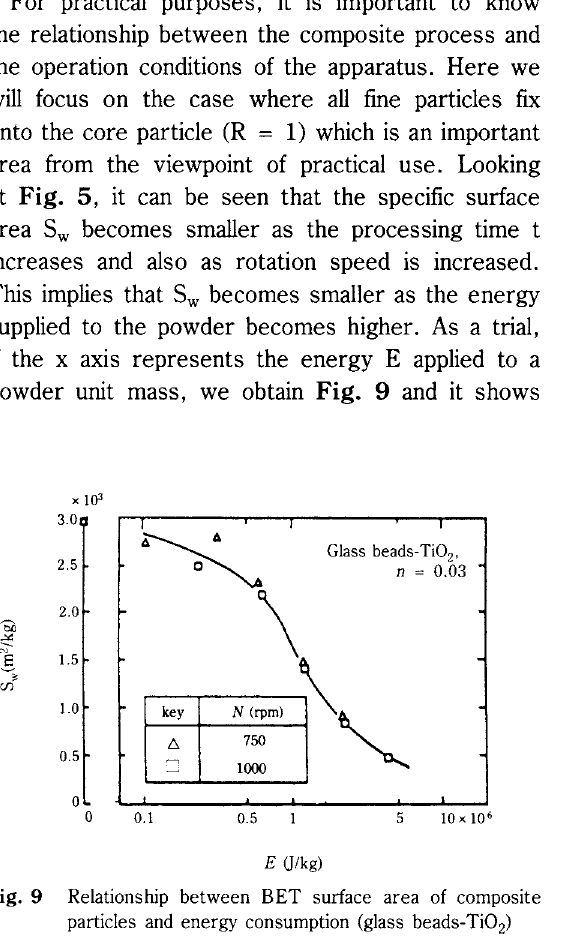
Relationship between BET surface area of composite particles and energy consumption (glass beads-Ti0 2)